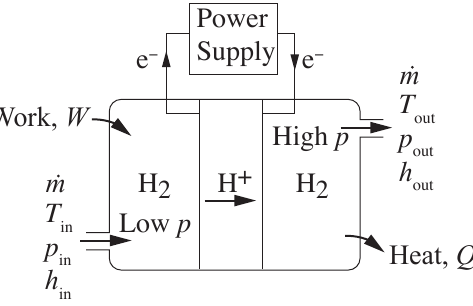
Figure 7. Compression across a proton conducting membrane.